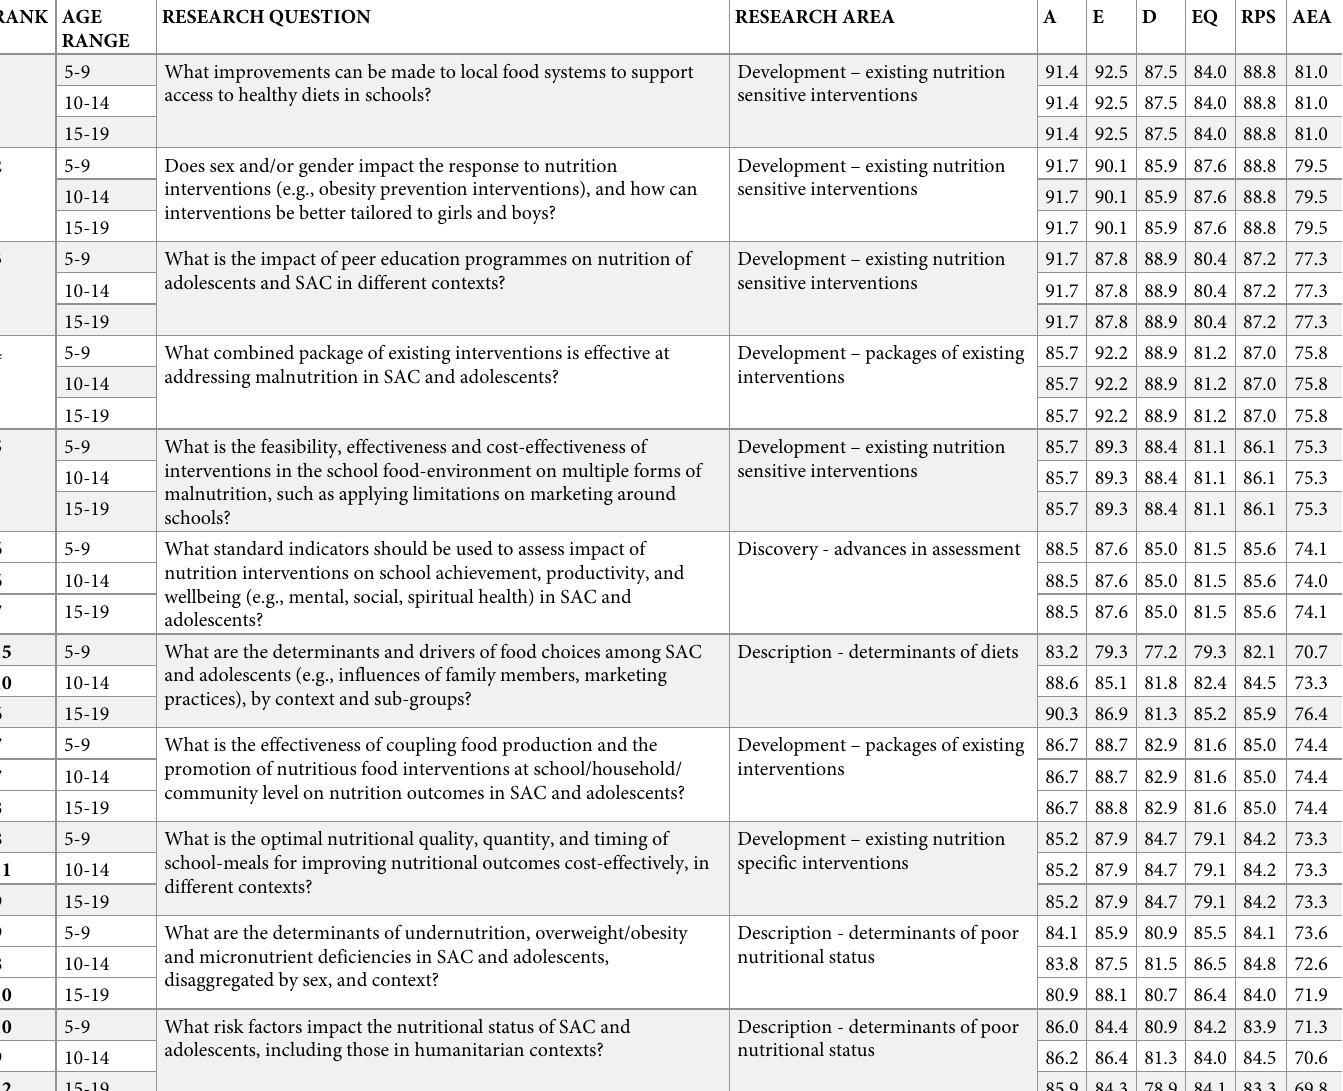
Table 3. Top ten ranked research questions disaggregated by age category. RANK AGE